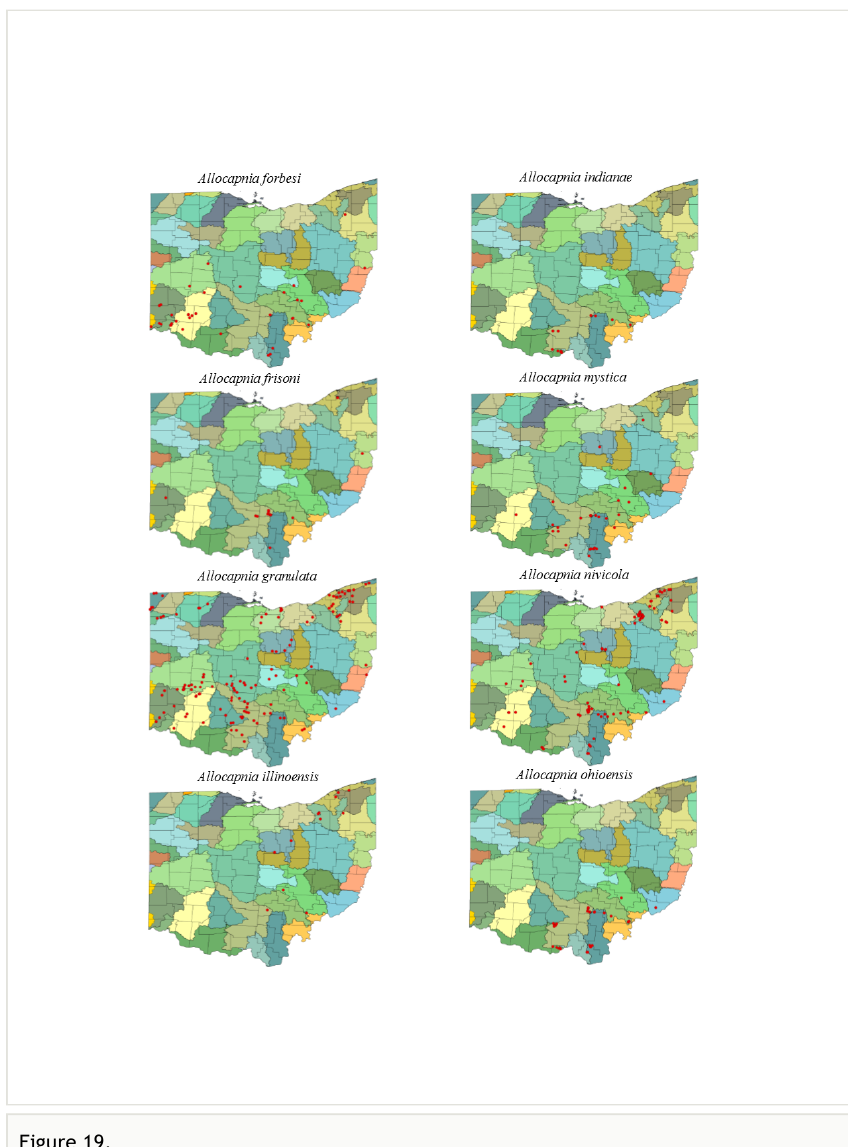
Figure 19. Distribution of Capniidae in